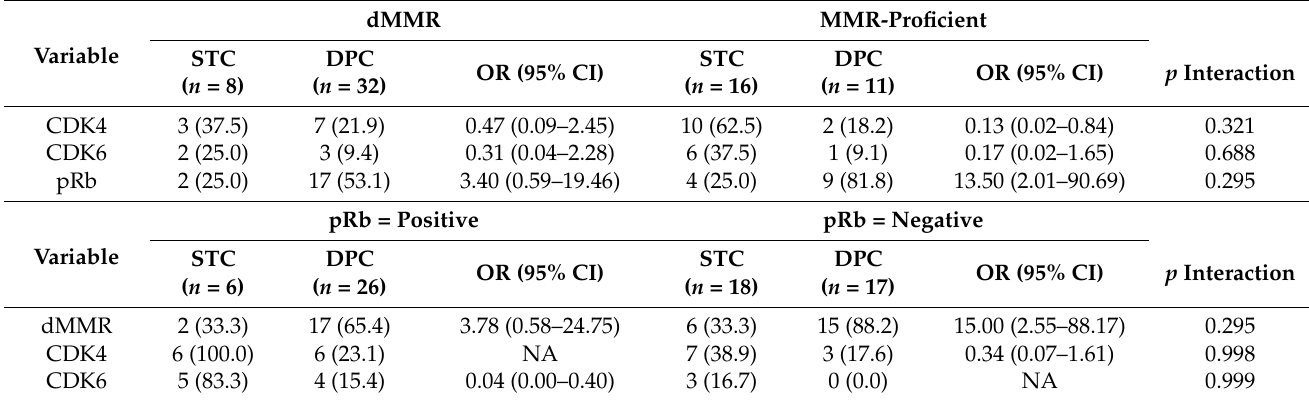
Table 4. The association between the major biomarkers and the status of STC/DPC stratified by the other major biomarkers.